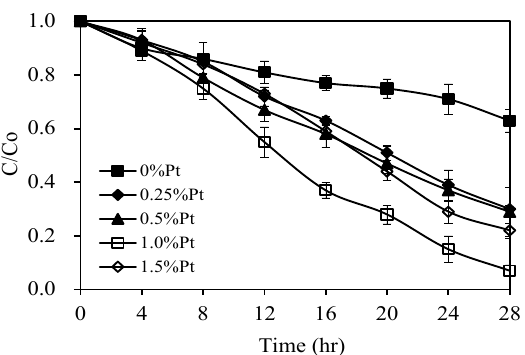
Figure 7. Photocatalytic activities of Pt/AgInS 2 catalysts with different Pt contents. Experimental conditions: pirimicarb concentration 10 mg L − 1 ; photocatalyst concentration 0.5 g L − 1 ; pH 5. Error bars represent the standard deviations of duplicate runs.